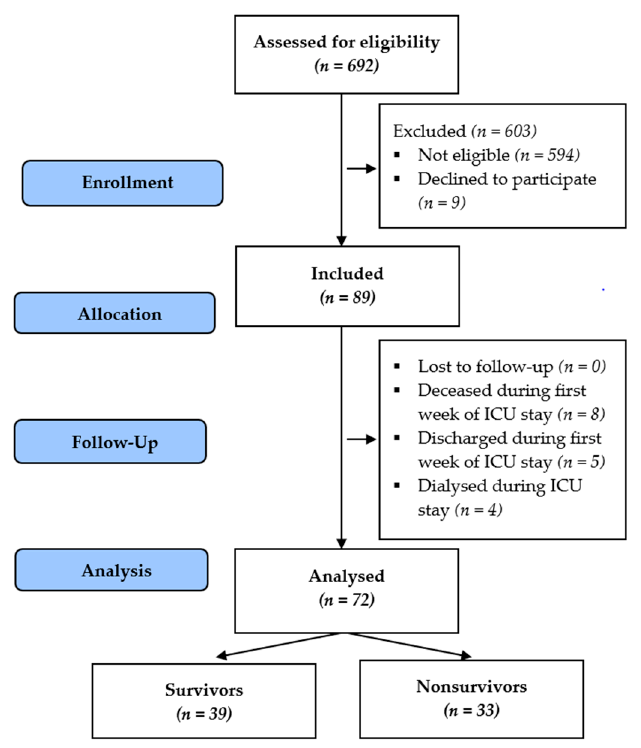
Figure 1. Flow chart of study cohort selection. Out of the 72 patients, 46 (64%) were males and 26 (36%) females. The average age of patients was 62 (16.8) years, and the mean ICU length-of-stay was 15 (4.4) days. Forty-six (64%) patients were admitted to the ICU for surgical reasons and 26 (36%) patients for medical conditions. Mean serum iron and ferritin levels on ICU admission were 57 (7.3) mcg/dL